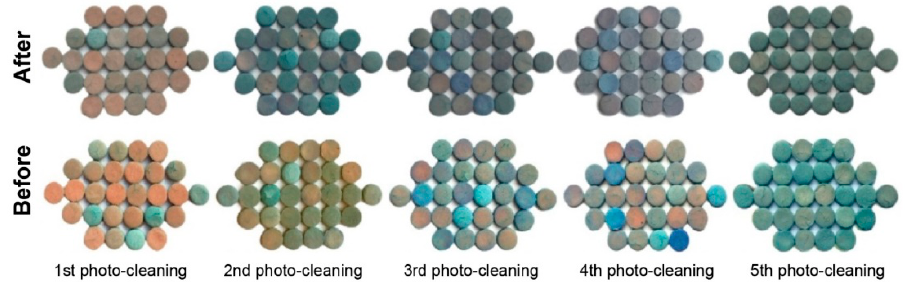
Figure 9. The 29 tablets of Fe 2 O 3 /TiO 2 /PVC composites after each photo-cleaning step used in the